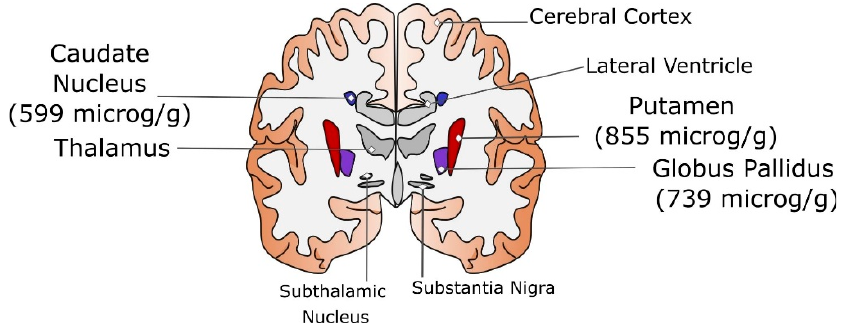
Figure 1. Sketch of the coronal section of the brain where several structures belonging to basal ganglia are detailed. For putamen, globus pallidus, and caudate nucleus, the mean iron levels (in µ g/g) reported by Ramos et al. [16] are given. The regions with the smallest value of deposited iron are filled in in blue, in red the highest ones are shown, and in violet the intermediate scores are given. The structures not analysed in detail are filled in in